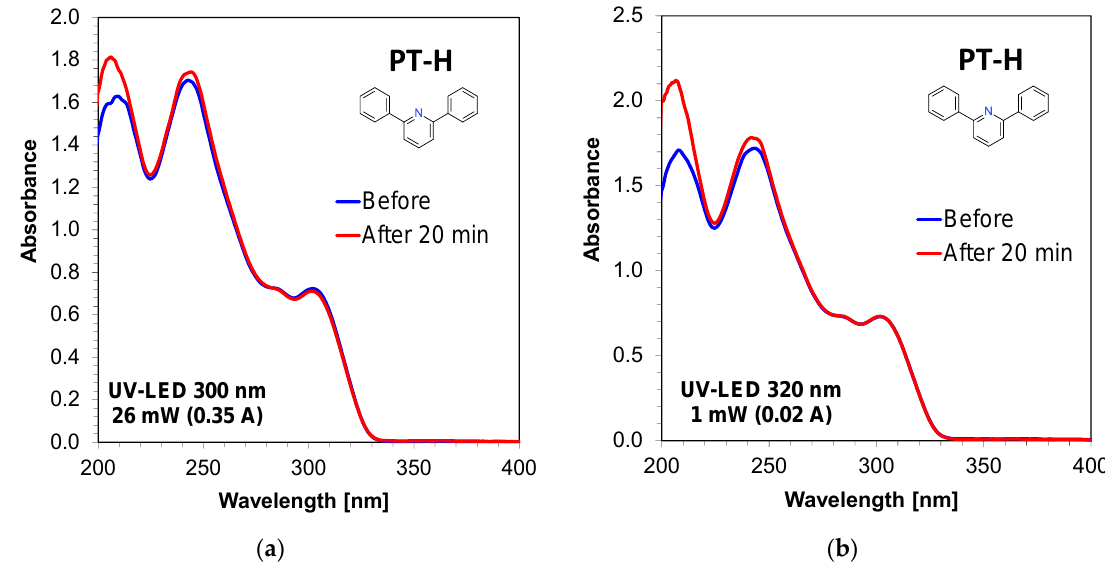
Figure 4. Photolysis of 2,6-diphenylpyridine (PT-H, concentration: 8.83 × 10 − 5 [mol / dm 3 ]) in ACN during 20 min: ( a ) under 300 nm (26mW / cm 2 ); ( b ) under 320 nm (1mW / cm 2 ).